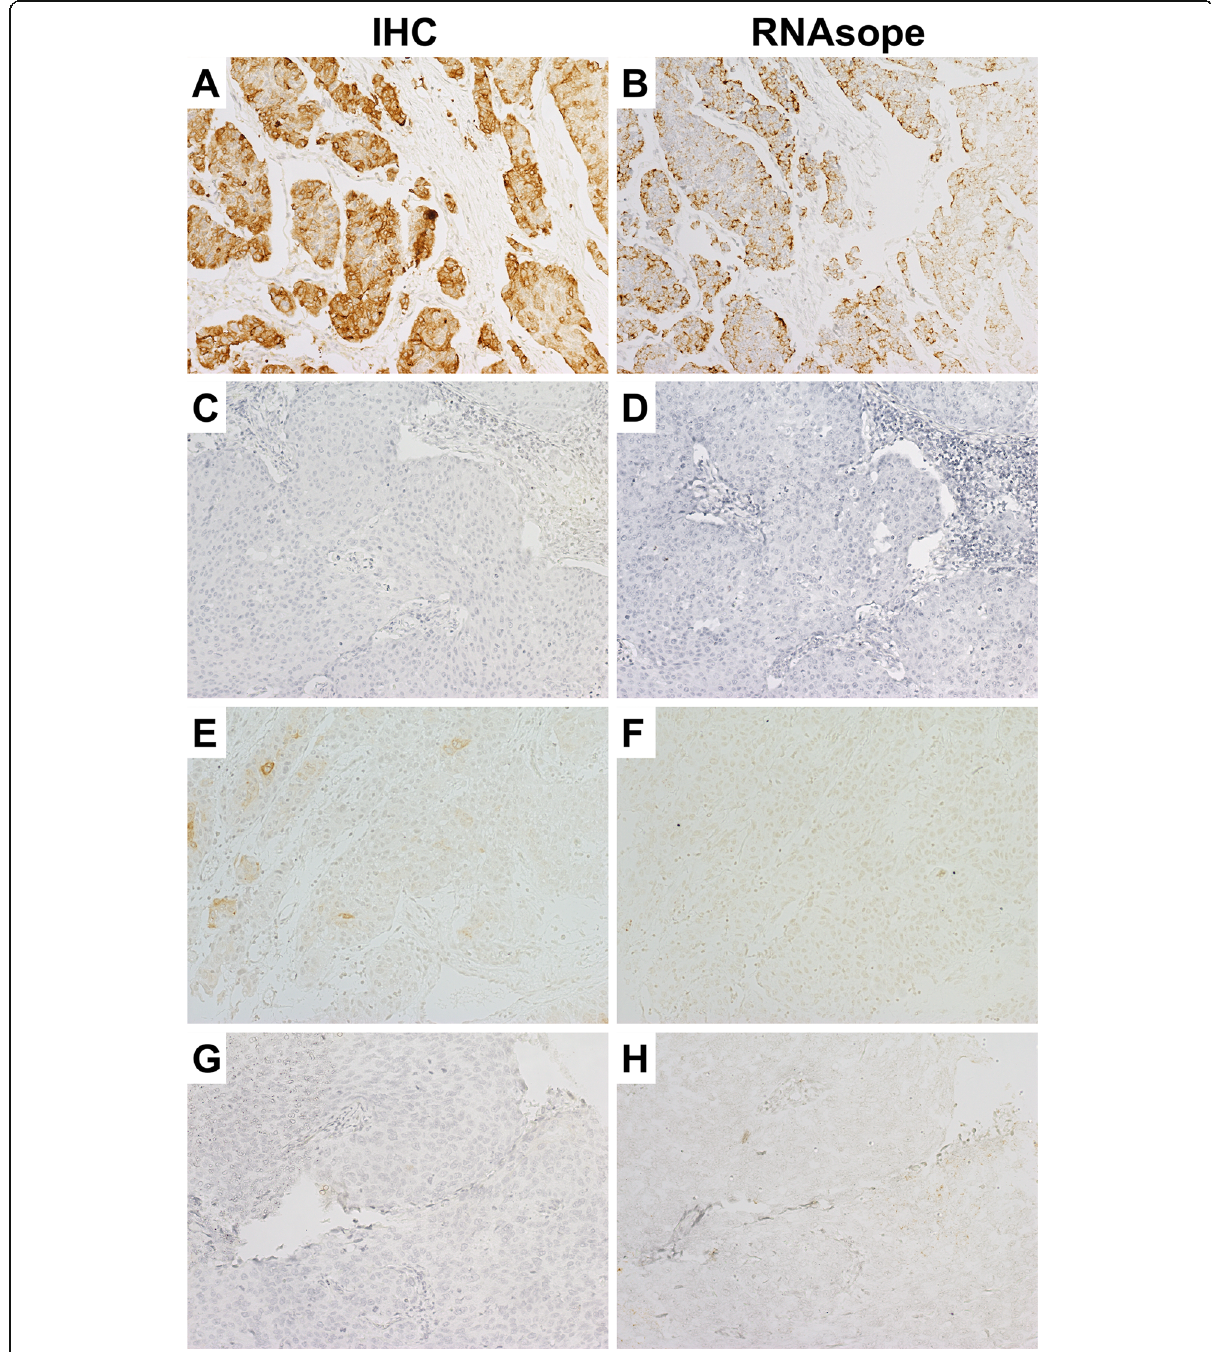
Fig. 1 Photomicrographs of urothelial carcinoma in which immunohistochemistry and RNAscope showed similar and different results for the UPK2 status under 200× magnification. A-B UPK2 expression was detected to be positive by both IHC and RNAscope. C-D UPK2 expression was detected to be negative by both IHC and RNAscope. E-F UPK2 expression was evaluated as positive by IHC and negative by RNAscope. G- H UPK2 expression was evaluated as negative by IHC and positive by